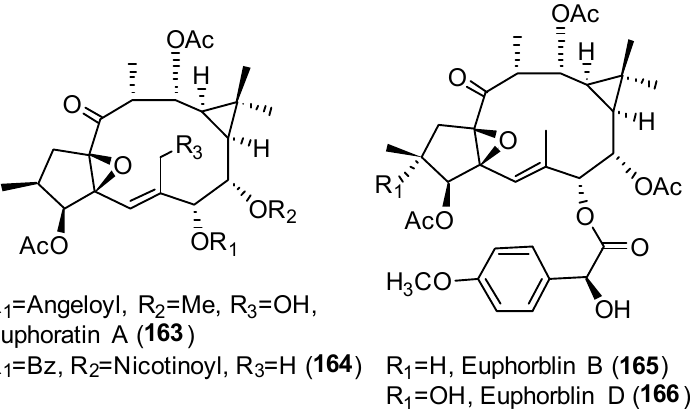
Figure 30. Ingol-type diterpenoids with the abilities to inhibit mouse 11 β -HDS1 ( 163 – 164 ) and to induce lysosomal biosynthesis ( 165 – 166 ).